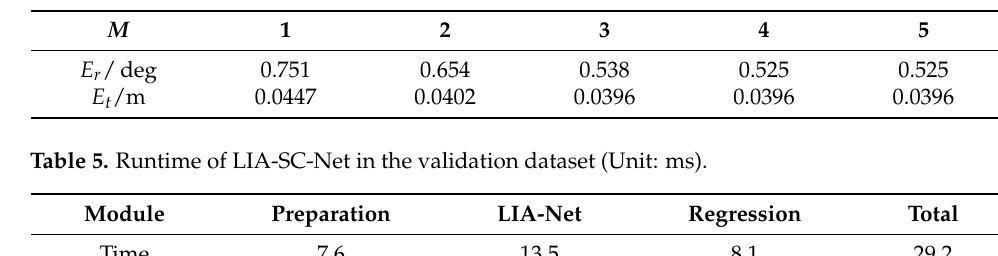
Table 4. Performance of iterative inference of LIA-SC-Net in the validation dataset.